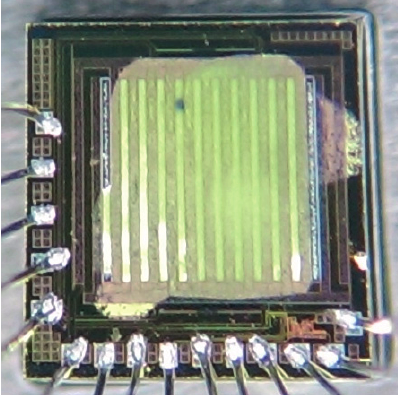
Figure 8. Optical image of the methanol sensor.